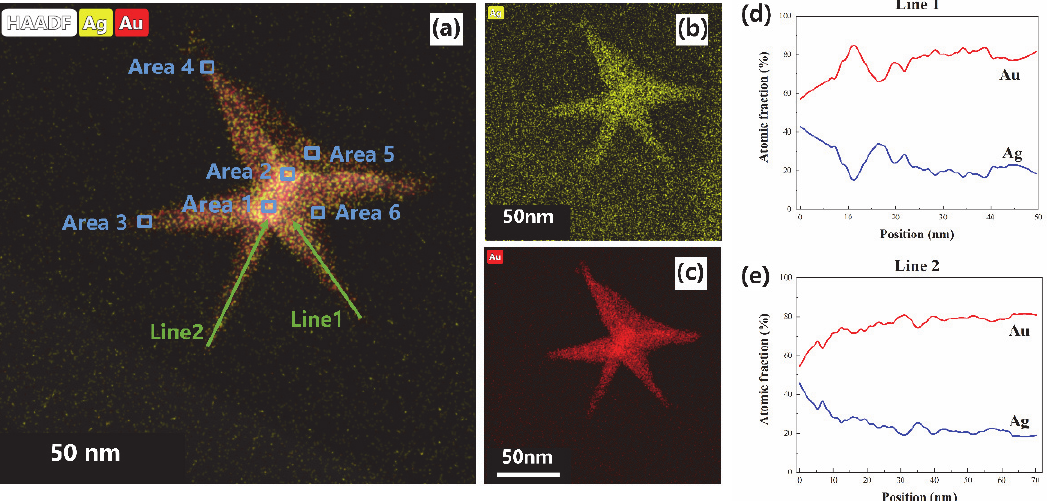
Figure 2. The XRD pattern ( a ), TEM image ( b ), inset was Fourier electron diffraction image, HR- TEM image ( c ), and Au-Ag nanostars synthesized with 50 mM LSB.